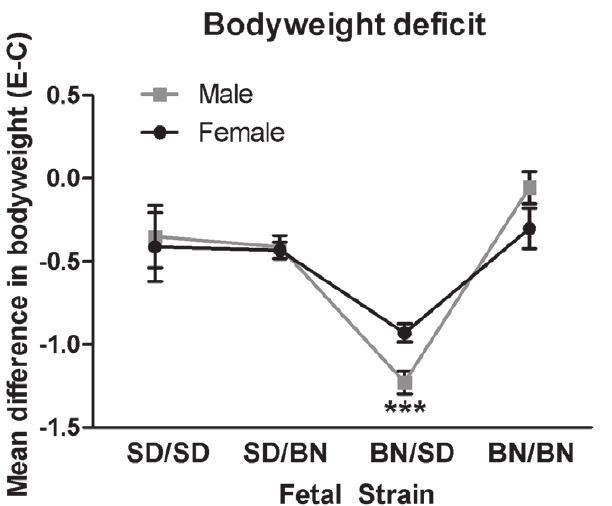
Figure 3. Unique bodyweight deficit of alcohol-exposed BN/SD illustrates the interaction of both parental genetic back- grounds in fetal vulnerability to alcohol. The difference in mean bodyweight between control and alcohol-exposed male and female fetuses is shown for the pure and hybrid fetal strains. There was no significant effect of fetal sex on bodyweight deficits; therefore, data were analyzed by one-way ANOVA with fetal strain as the factor. Bodyweight deficits exhibited by BN/SD fetuses were significantly greater than all other strains (fetal strain: F [3,30]=25.8, P , 0.0001) including the BN/BN fetuses of the same mother, illustrating a maternal- paternal interaction of genetic background. *** P , 0.001 by Bonferroni post-hoc test.